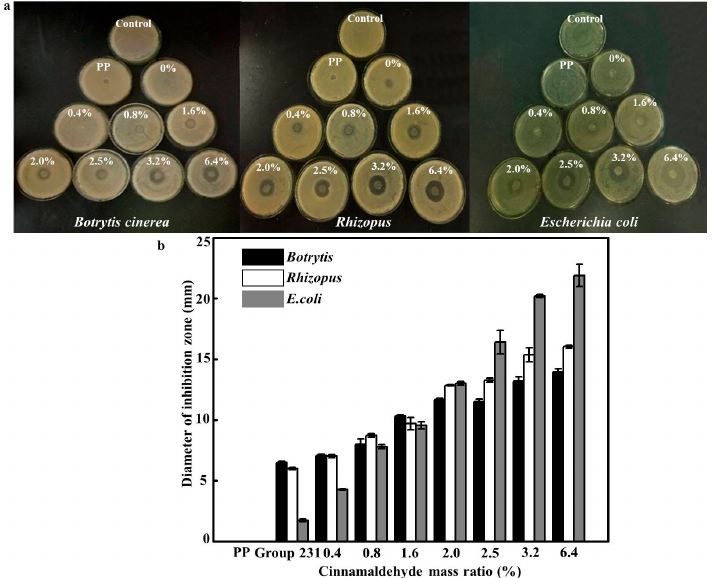
ff ects of CS / corn starch / cinnamaldehyde films ( p < Figure 4. The bacteriostatic effects of CS/corn starch/cinnamaldehyde films ( p < 0.05). Figure 4. The bacteriostatic e